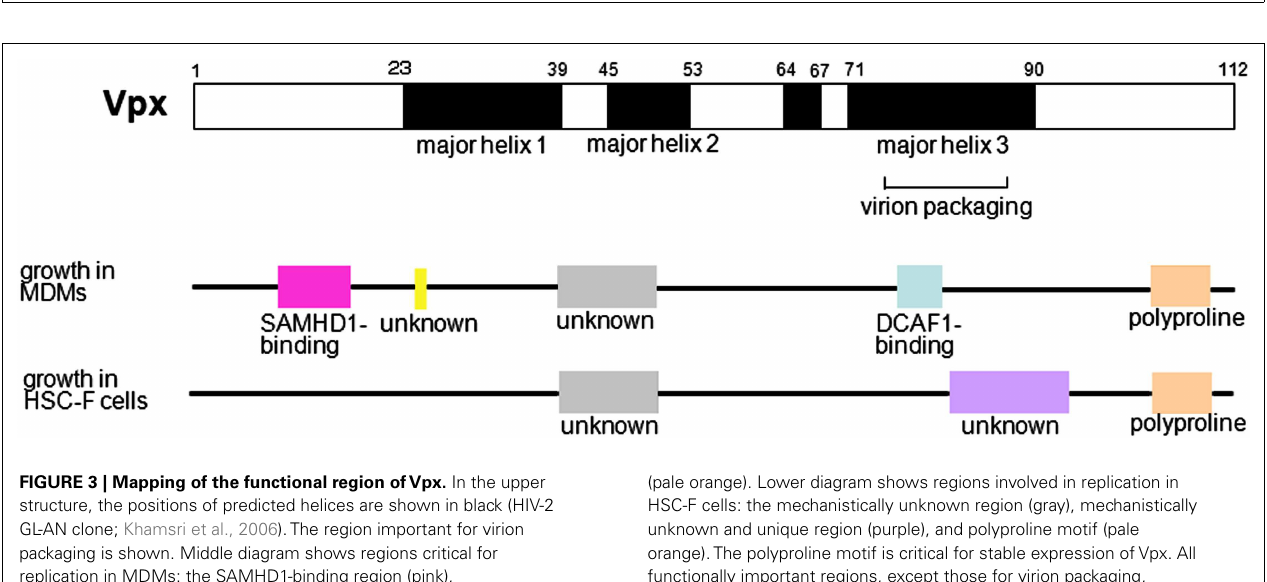
FIGURE 3 | Mapping of the functional region ofVpx. In the upper structure, the positions of predicted helices are shown in black (HIV-2 GL-AN clone; Khamsri et al., 2006).The region important for virion packaging is shown. Middle diagram shows regions critical for replication in MDMs: the SAMHD1-binding region (pink), mechanistically unknown amino acid (yellow), mechanistically unknown region (gray), DCAF1-binding region (light blue), and polyproline motif